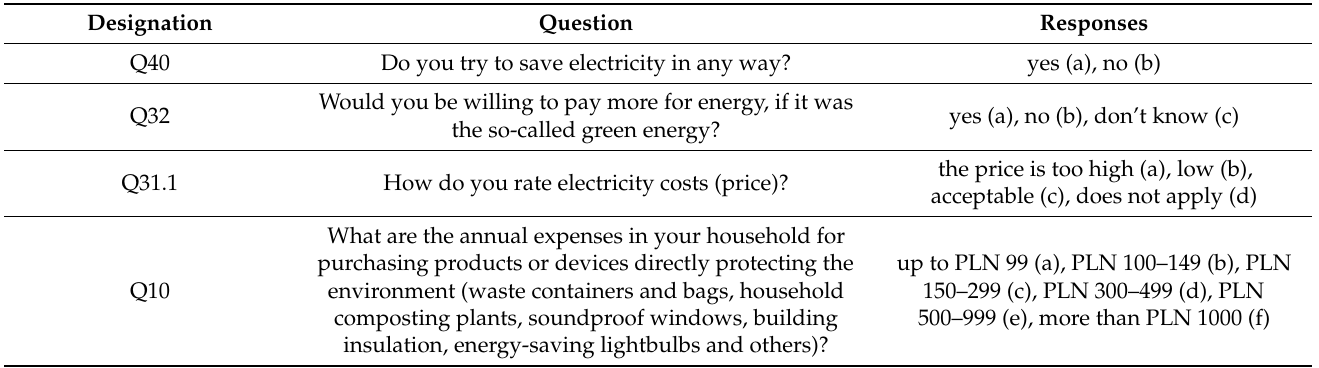
Table 1. Questions used for respondent segmentation together with possible answers.